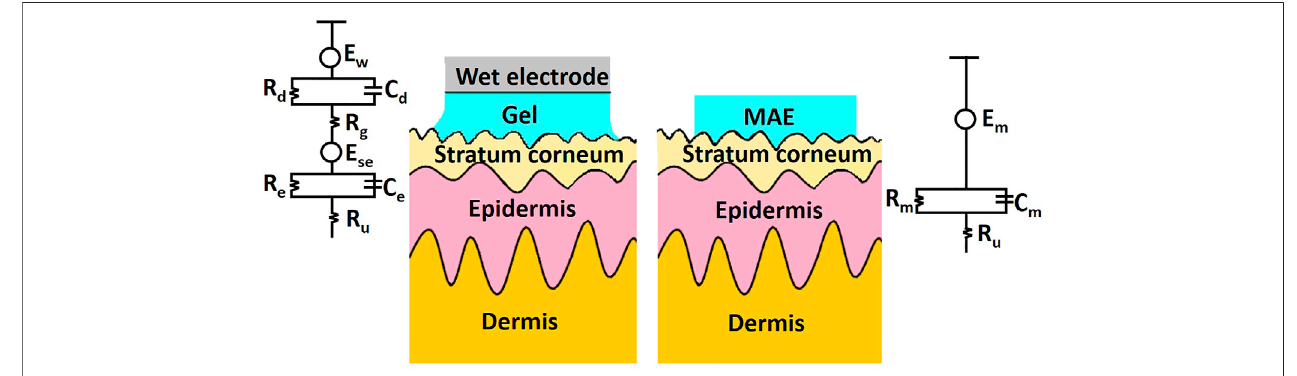
FIGURE 7 | Schematic and electrical equivalent circuit model of wet electrodes and MAE, respectively.